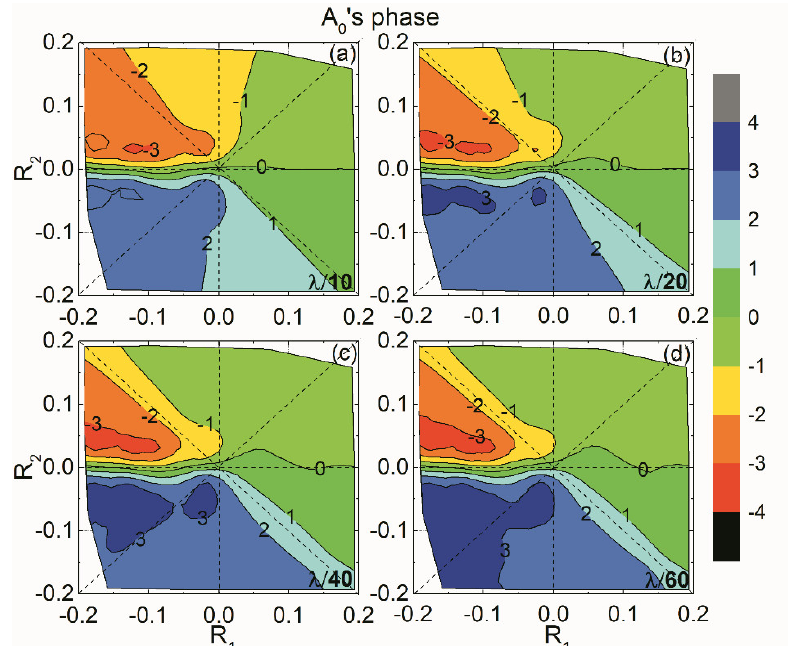
Figure 11. A 0 ’s phase of 120 thin-bed models with different thickness, R 1 or R 2 .